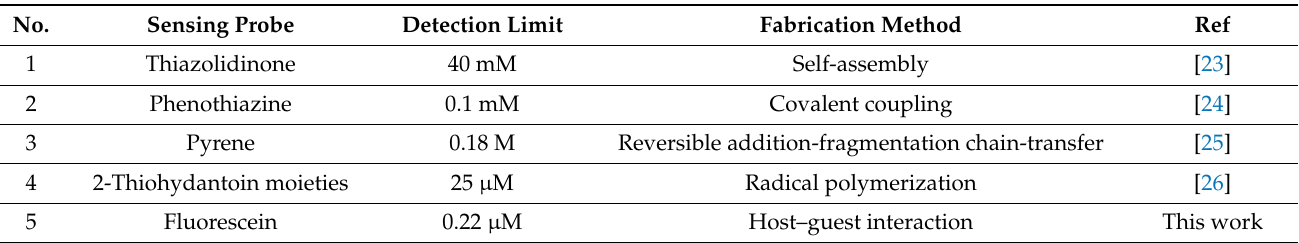
Table 2. Comparison table for hydrogel sensor systems.